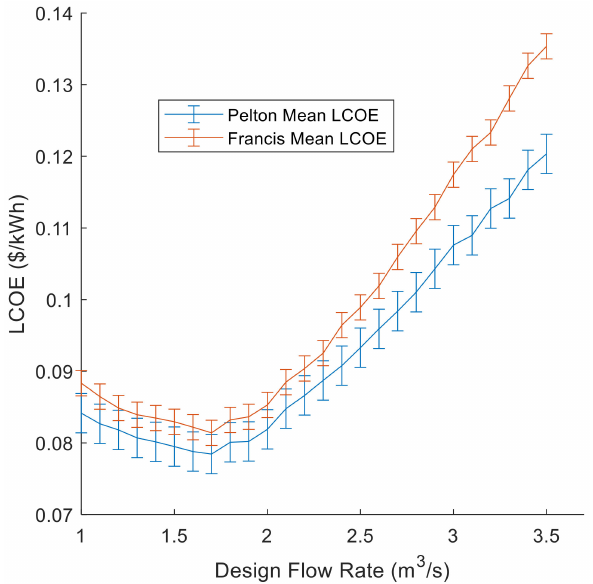
Figure 9. The LCOE ($/kWh) for Francis and Pelton at varying designed flow rate (m 3 /s) and a constant head of 70 m. Error bars indicate 95% confidence intervals for each simulated LCOE